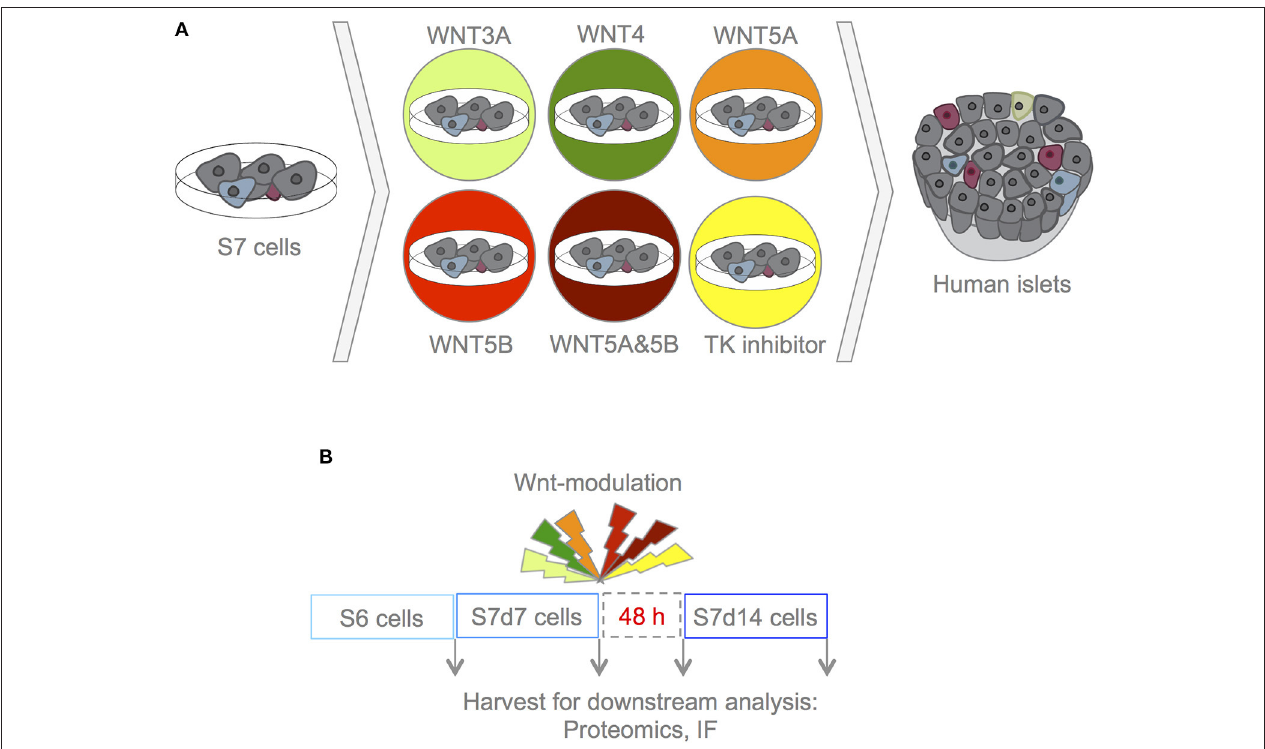
FIGURE 1 | Experimental design. (A) With this experimental set-up we aimed to assess whether Wnt-modulation could drive maturation of S7 cells toward a phenotype that closer resembles that of β -cells as found in adult human islets. To assess the effects of Wnt-modulation of S7 cells, the Wnt-modulated cells were compared to un-stimulated S7 cells as well as to adult human islets. (B) S7d7 cell cultures were treated for 4h with either WNT3A (light green), WNT4 (green), WNT5A (orange), WNT5B (red), a combination of WNT5A&5B (dark red) for stimulation of the canonical or non-canonical Wnt pathways, or TKi (yellow) to block endogenous Wnt signaling in S7d7 cell cultures. The Wnt-modulated S7 cells were maintained in differentiation culture for 48h prior to harvest for downstream analysis [including proteomics analysis and immunofluorescence